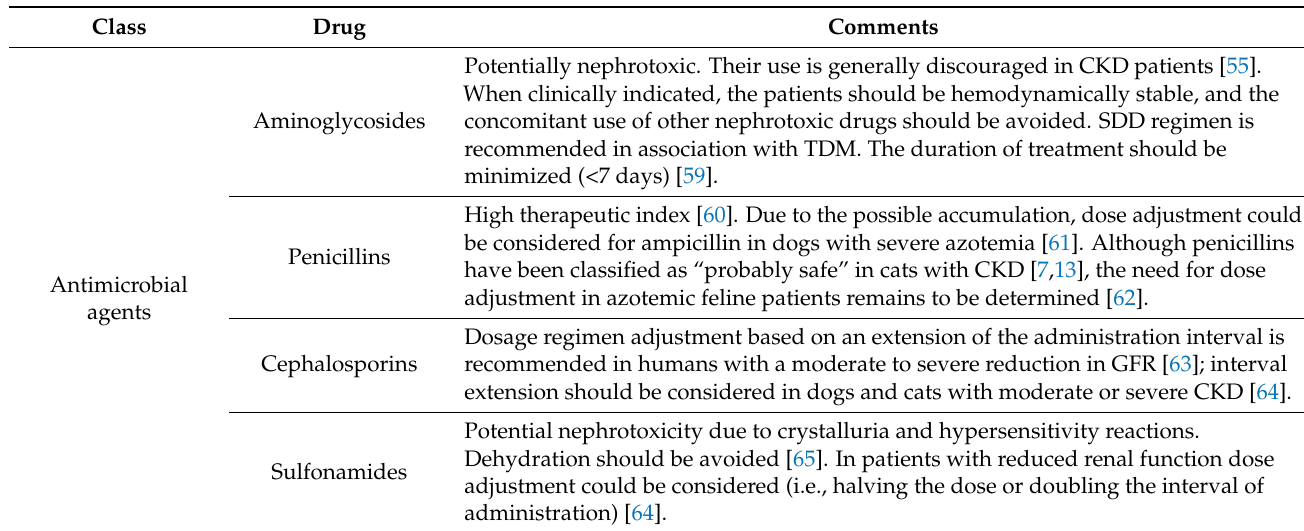
Table 1. Summary of the main recommendation on the use of the revised class of drugs in patients with impaired renal function. CKD: chronic kidney disease; SDD: single daily dose; TDM: